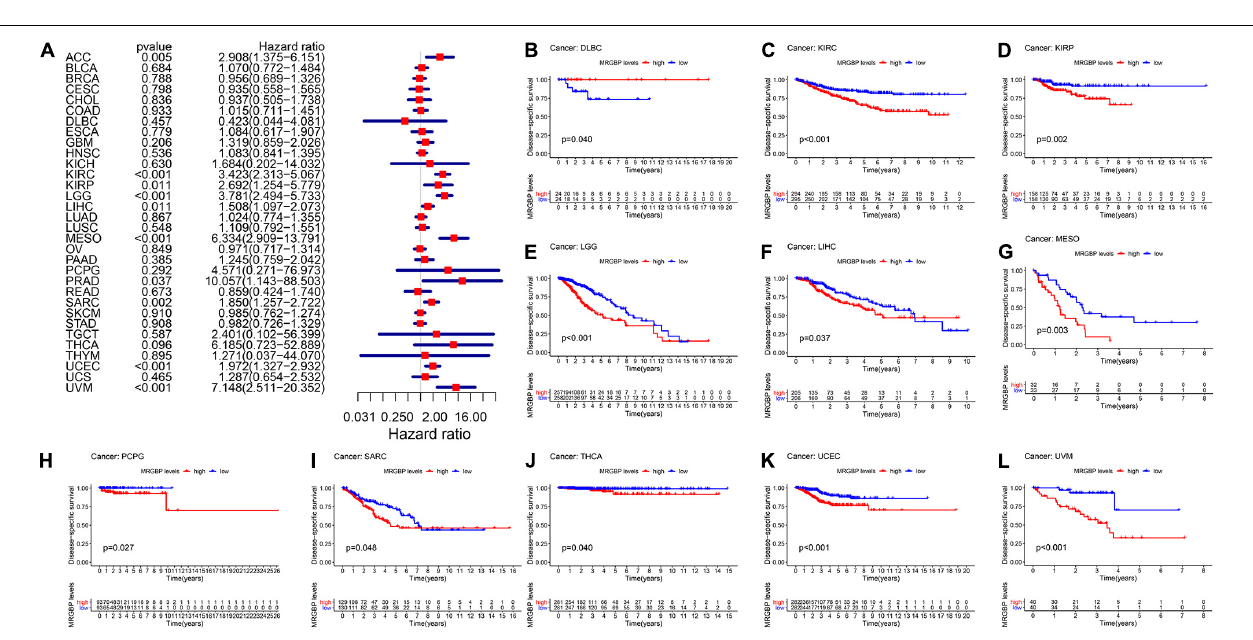
FIGURE 3 | Relationship between MRGBP expression and disease-specific survival (DSS) in 33 tumors. The forest plots were calculated using univariate Cox regression (A) and the survival curves were calculated using Kaplan-Meier survival methods (B–L) .